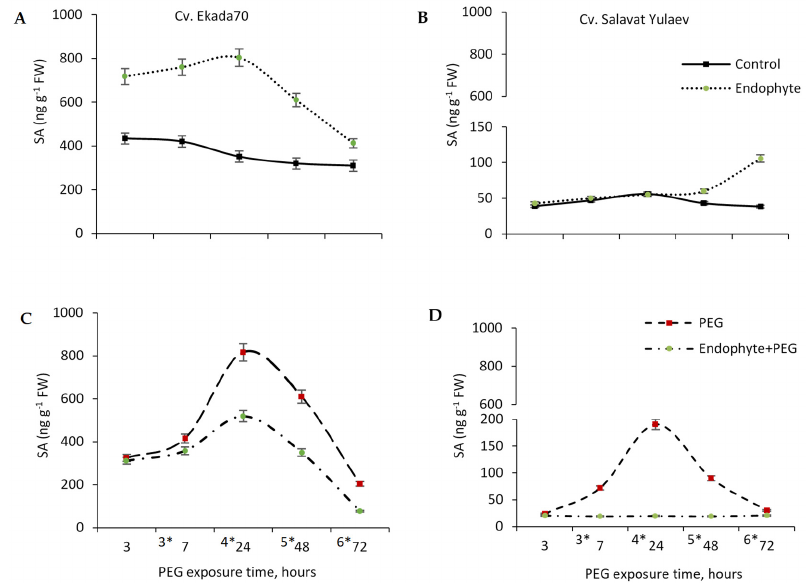
Figure 8. Effect of endophytic B. subtilis 10-4 (endophyte) inoculation on endogenous salicylic acid (SA) content in wheat seedlings of cv. Ekada70 (drought-tolerant) ( A , C ) and cv. Salavat Yulaev (drought-sensitive) ( B , D ) under normal ( A , B ) and drought (12% PEG-6000) (PEG) ( C,D ) conditions. The bars are the means of three repetitions ± SEM. Different letters indicate a significant difference between the means at the probability level of p < 0.05. FW, fresh weight. 3 *—three days old seedlings, 4 *—four days old seedlings, 5 *—five days old seedlings, 6 *—six days old seedlings.